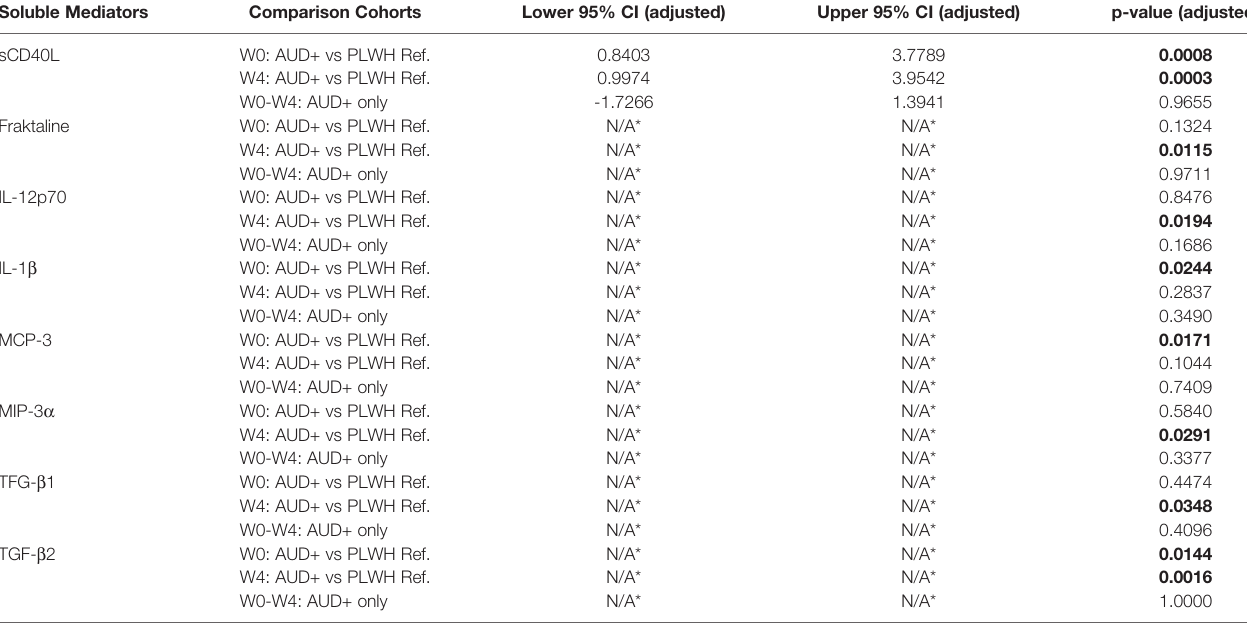
TABLE 5 | Signi fi cant differences in plasma cytokines between PLWH with and without AUD. Soluble